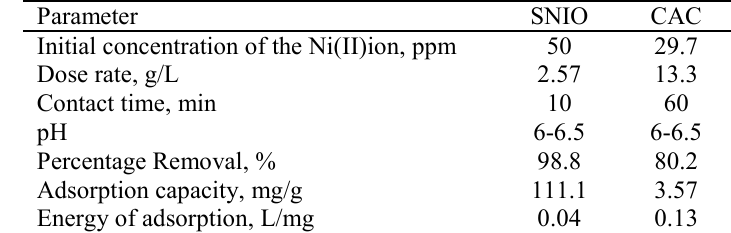
Initial concentration of the Ni(II)ion,